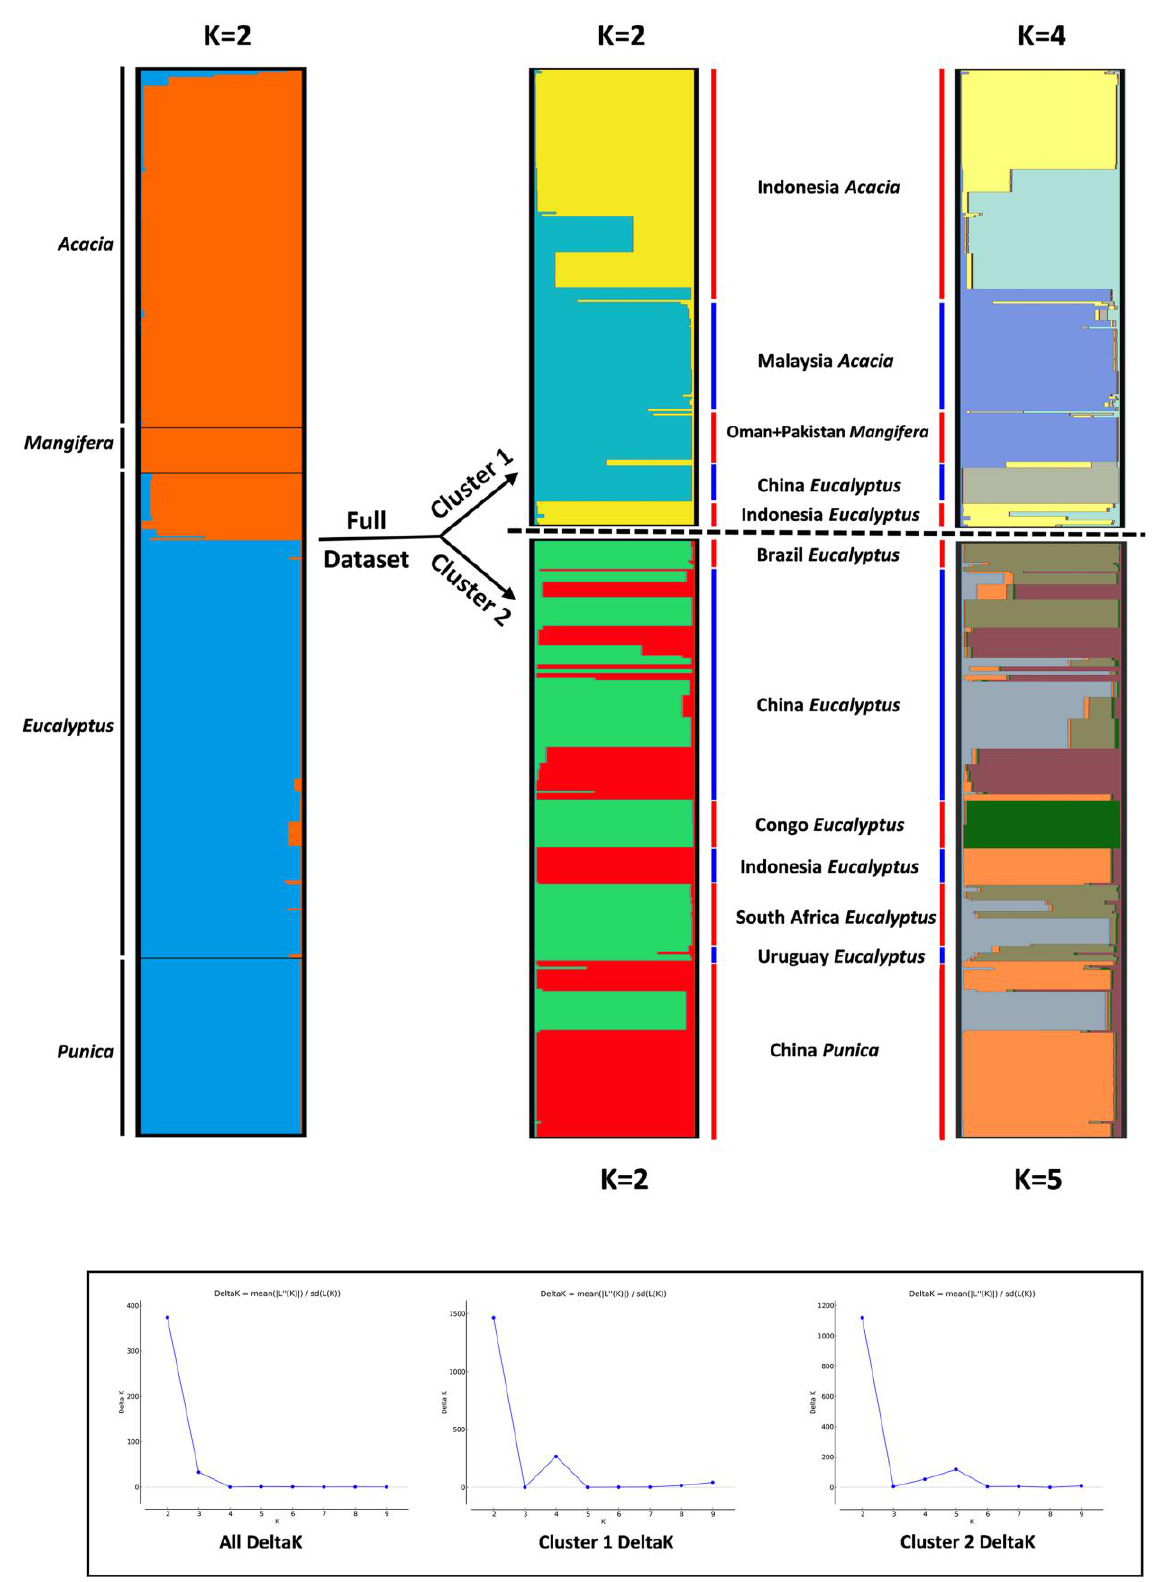
Figure 4. Cluster analyses of isolates in the C. manginecans complex inferred using two rounds of hierarchical STRUCTURE analyses. Each individual is represented by a bar, divided into K colors, where K is the possible number of clusters. Arrows delineate the progress of the hierarchical approach, where subsets of the data were subsequently analyzed. For each cluster, ∆ K is plotted in the bottom.